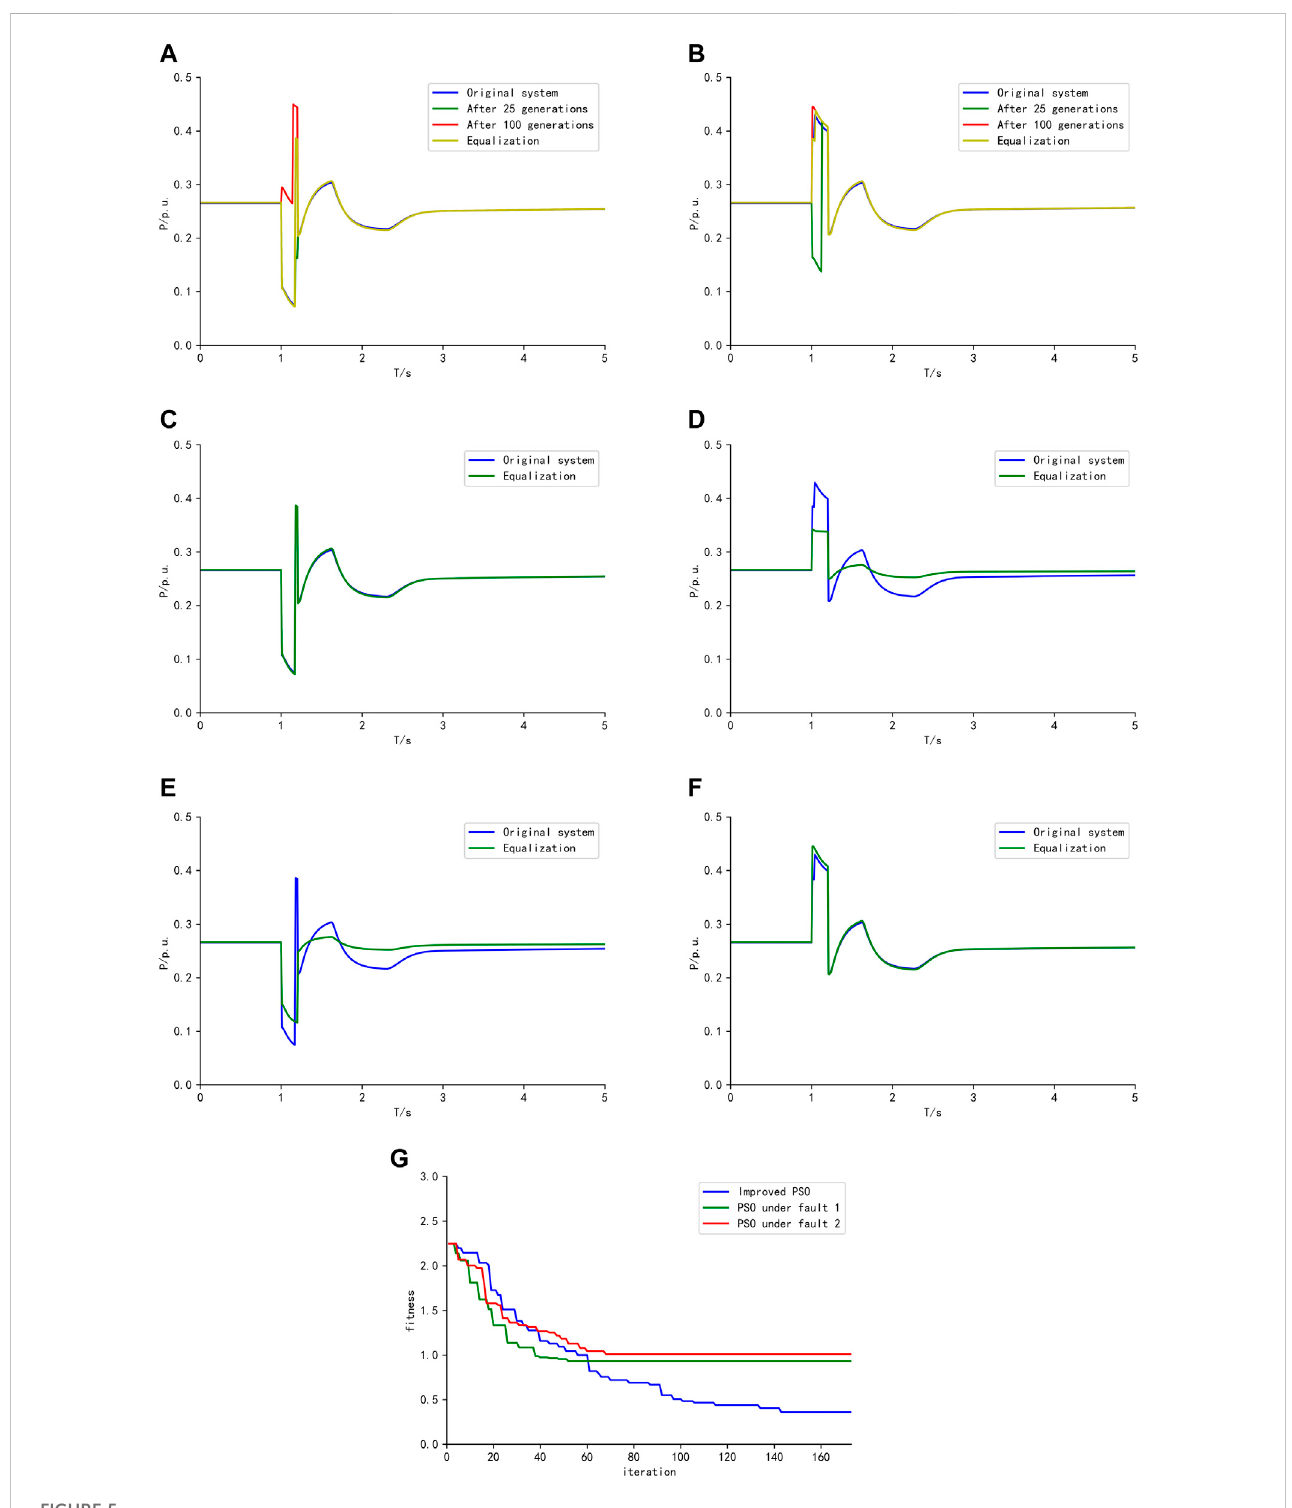
FIGURE 5 Comparison of equivalent results. (A) Improved PSO optimization process under fault 1, (B) Improved PSO optimization process under fault 2, (C) PSO under fault 1, (D) PSO under fault 2, (E) PSO under fault 1, (F) PSO under fault 2, (G) Sum of the fi